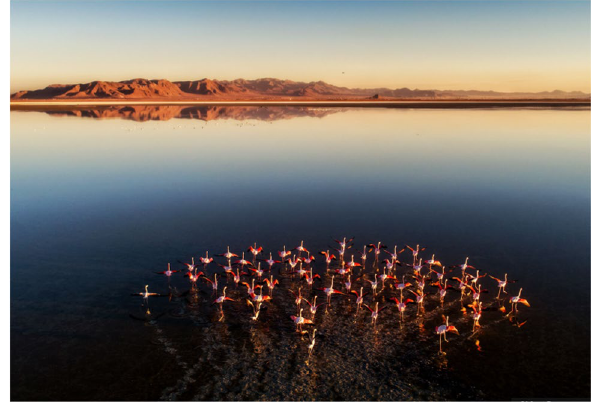
Fig. 7 Meighan wetland, a desert wetland in